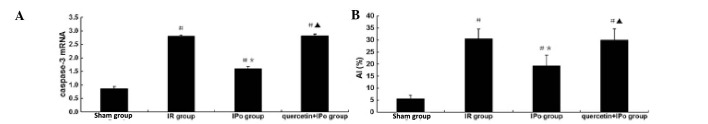
(A) Expression of caspase-3 mRNA and (B) AI, in the four experimental groups at 6 h post-reperfusion. #P<0.05, as compared with the sham group; *P<0.05, as compared with the IR group; ▲P<0.05, as compared with the IPo group. AI, apoptotic index; S, control group; IR, ischemia-reperfusion; IPo, ischemic postconditioning.